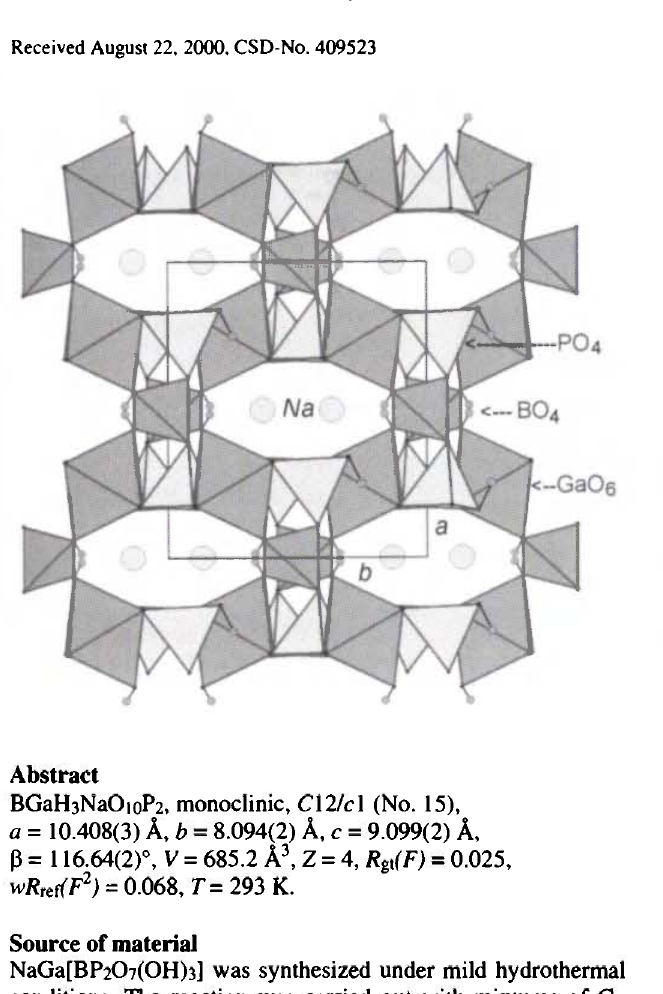
Table 1. Data collection and handling.